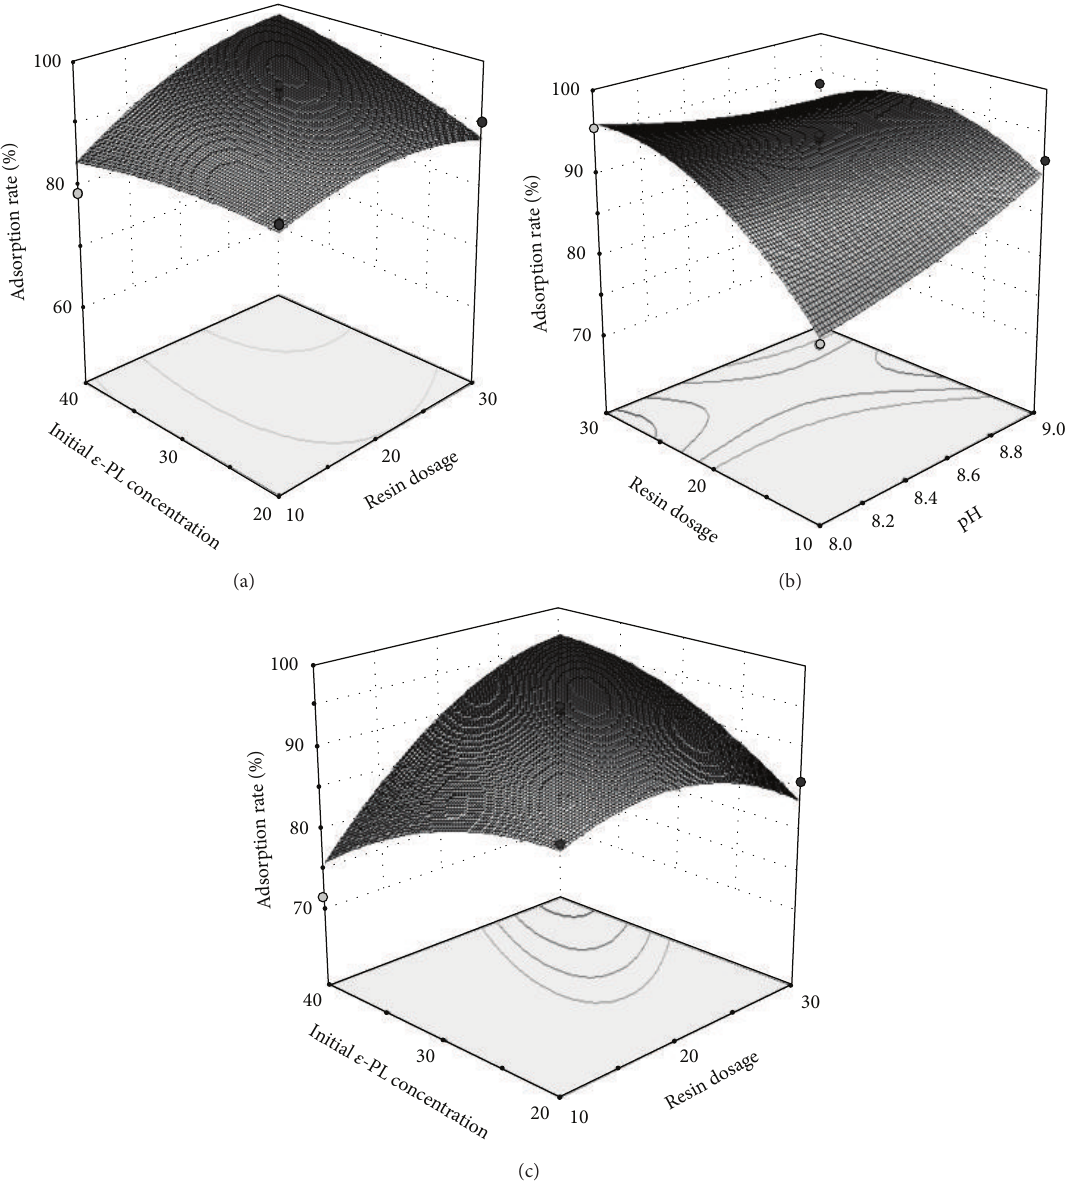
Figure 2: Response surface plots for the effects of interactions between variables on the adsorption efficiency. (a) Initial 𝜀 -PL concentration and resin dosage, HZD-3 resin; (b) resin dosage and pH, D155 resin; (c) initial 𝜀 -PL concentration and resin dosage, D155